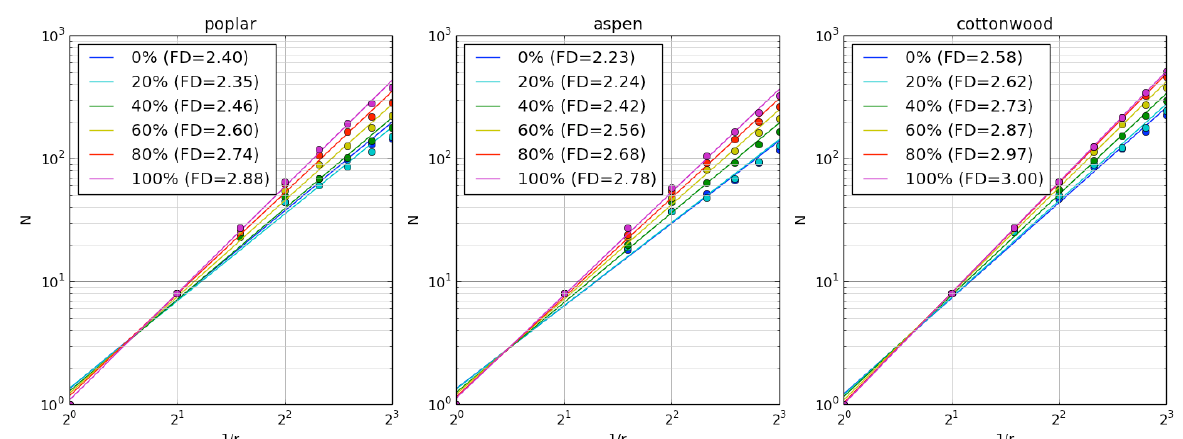
Figure 8: Relationship between the box count and the reciprocal box size for simulated point clouds from individual trees. Box size was chosen as an integer division of the scene-bounding box. The fractal dimension (slope) increases as clumping is reduced towards more uniform foliage distributions.